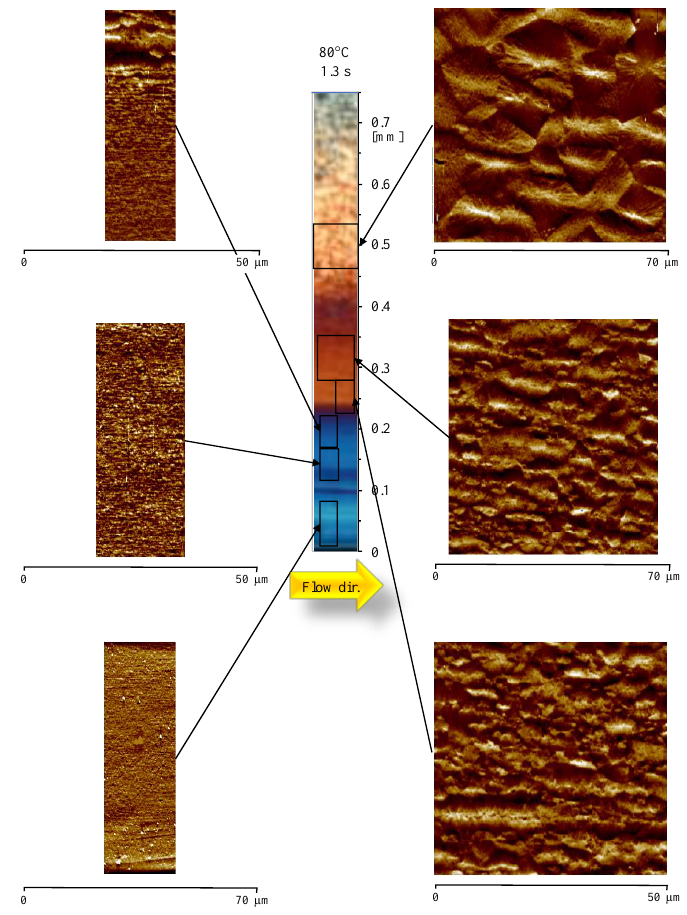
Figure 7. Optical micrograph and AFM height maps, at different distances from the sample surface, of the sample 80-1, at 15 mm downstream the gate.